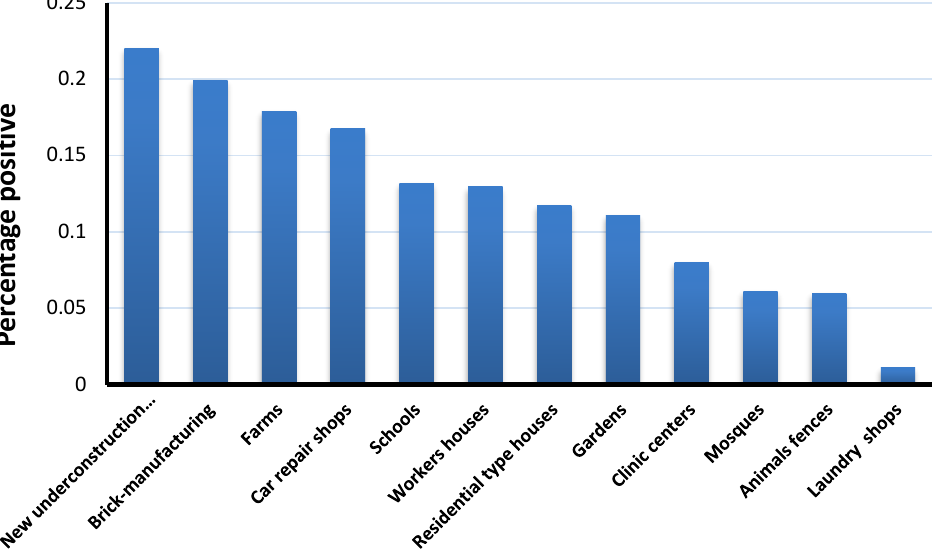
Figure 2. Aedes aegypti larval breeding sites.